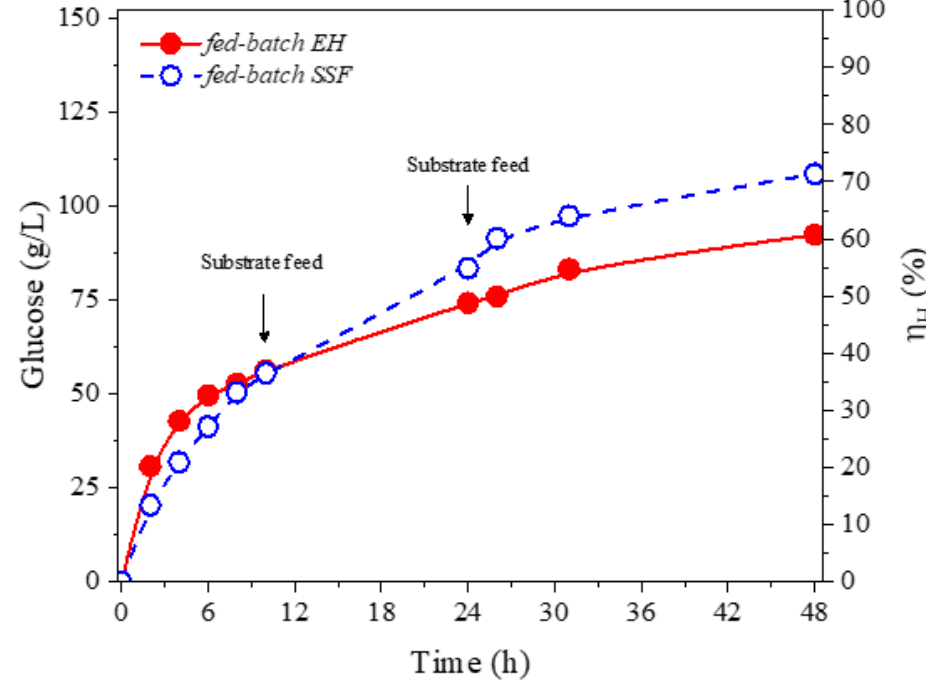
Figure 5. Time course for enzymatic hydrolysis (EH) and simultaneous saccharification and fermentation (SSF) of pre-treated rice straw at 24% ( w / v ) solid loading under the fed-batch mode using the FBS-3 strategy.